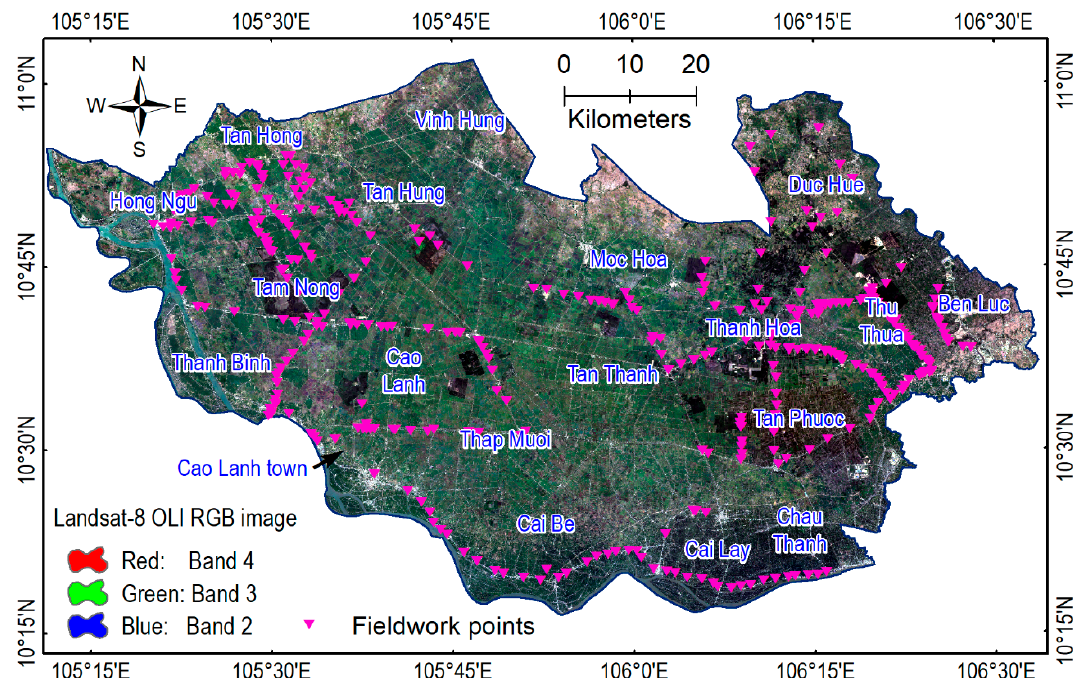
Figure 2. Locations of the fieldwork sites from April 2020 in the Dong Thap Muoi area. OLI: Operational Land Imager. RBG: Read, Green, and Blue.